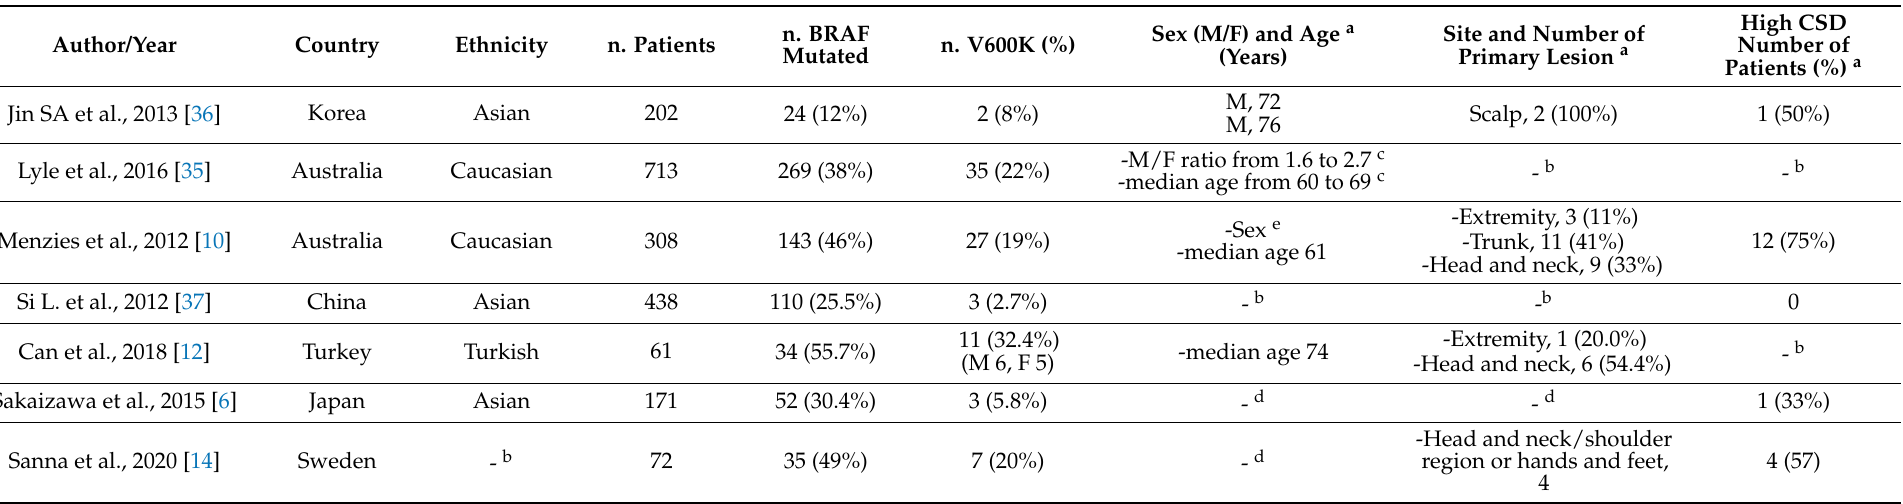
Table 1. Patient characteristics among different studies.